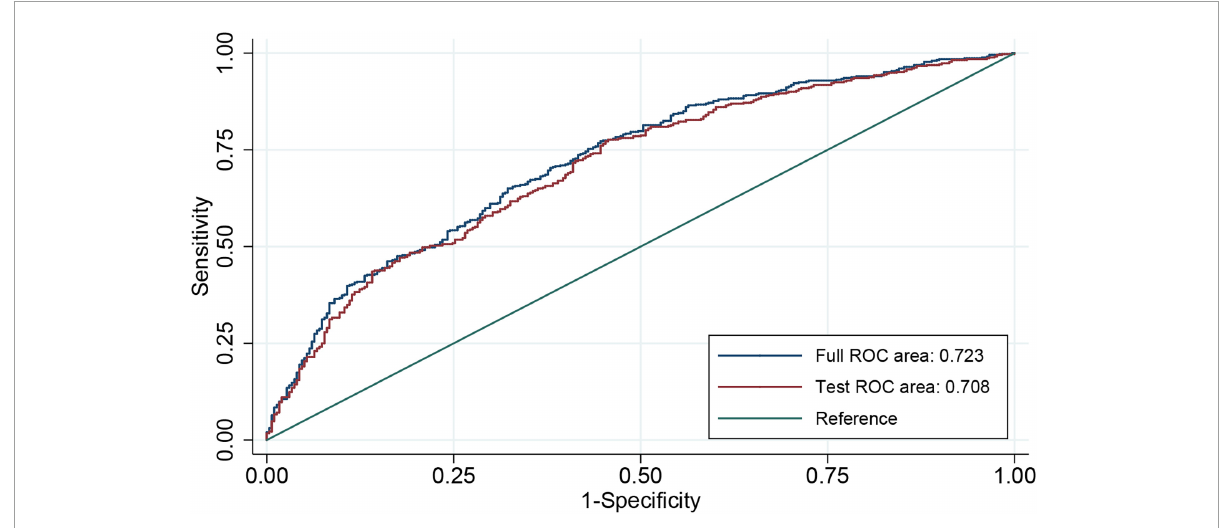
FIGURE5 ROC curve for 10-fold cross-validation. ROC, receiver operating